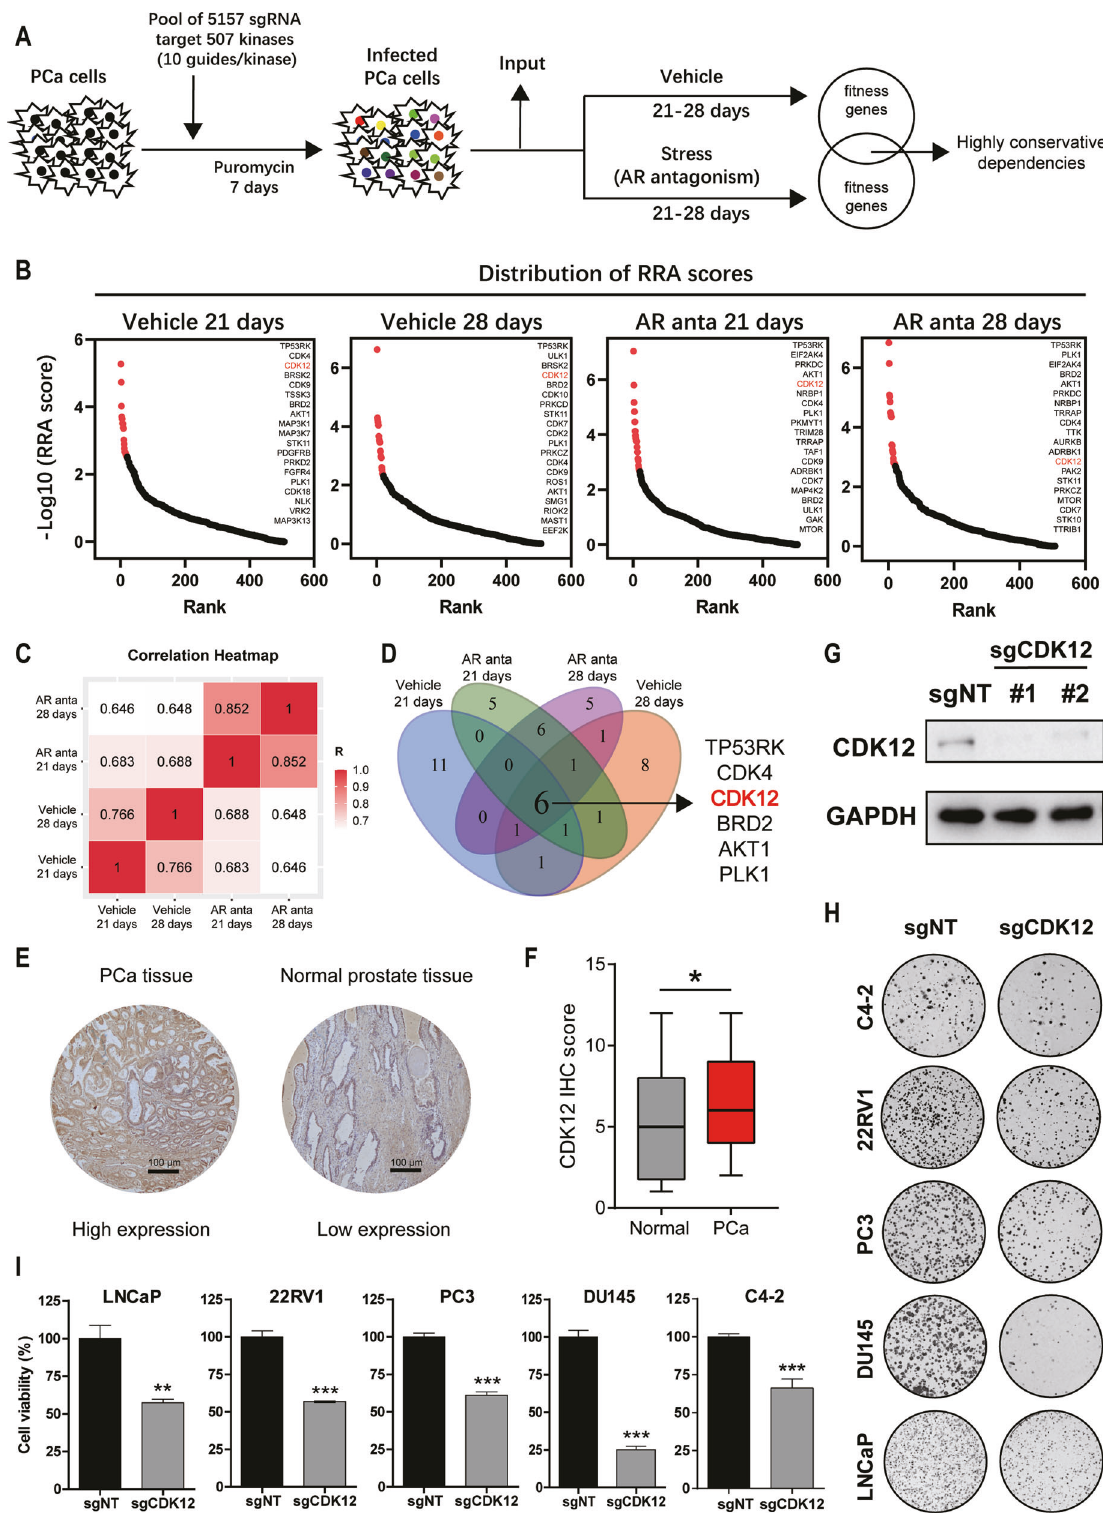
Fig. 1 CRISPR/Cas9 screening to identify genes critically required for PCa. A Schematic illustration of CRISPR/Cas9 screening to identify conserved kinases in C4 – 2 cells cultured with normal or 10 – 25 μ M enzalutamide. B RRA scores for the kinome. The top 20 candidate genes are marked in red. C Heatmap showing the correlation of the kinome among the normal and AR antagonism groups on the 21st and 28th days. D Venn diagram showing the overlap of the top 20 candidate genes from each group. E Typical images of immunostaining of the CDK12 protein in PCa and normal prostate tissues. The scale bars represent 100 µm. F IHC score of the CDK12 protein levels in PCa and normal prostate tissues. G Level of CDK12 knockout in PCa cells, as measured by western blotting. H PCa cell proliferation assessed by the colony formation assay. I PCa cell viability assessed by the CCK-8 cell viability